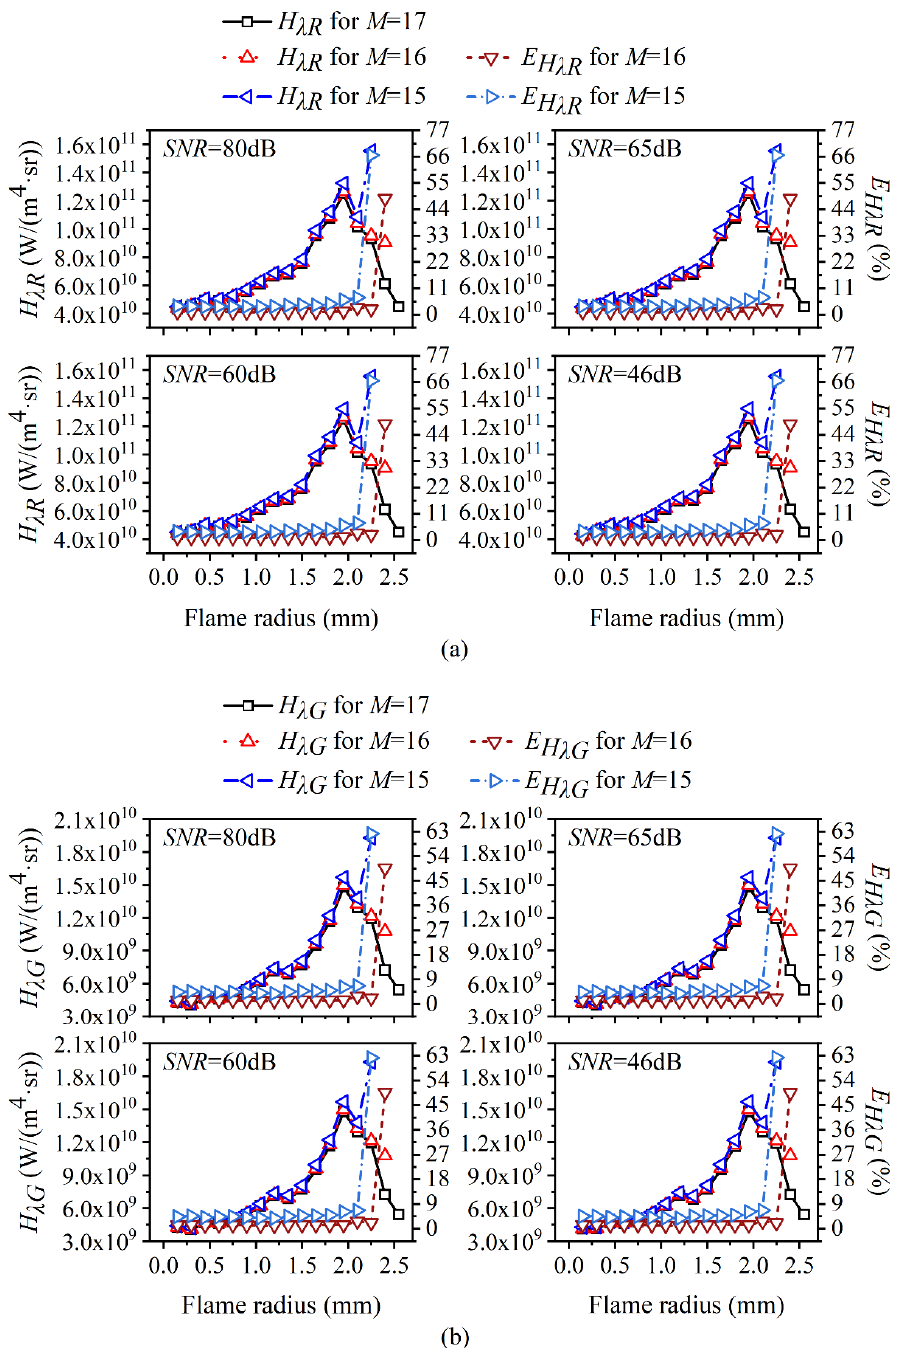
Figure 9. The influence of edge effect on the reconstruction of ( a ) H λ R ; ( b ) H λ G under different cases of SNR .